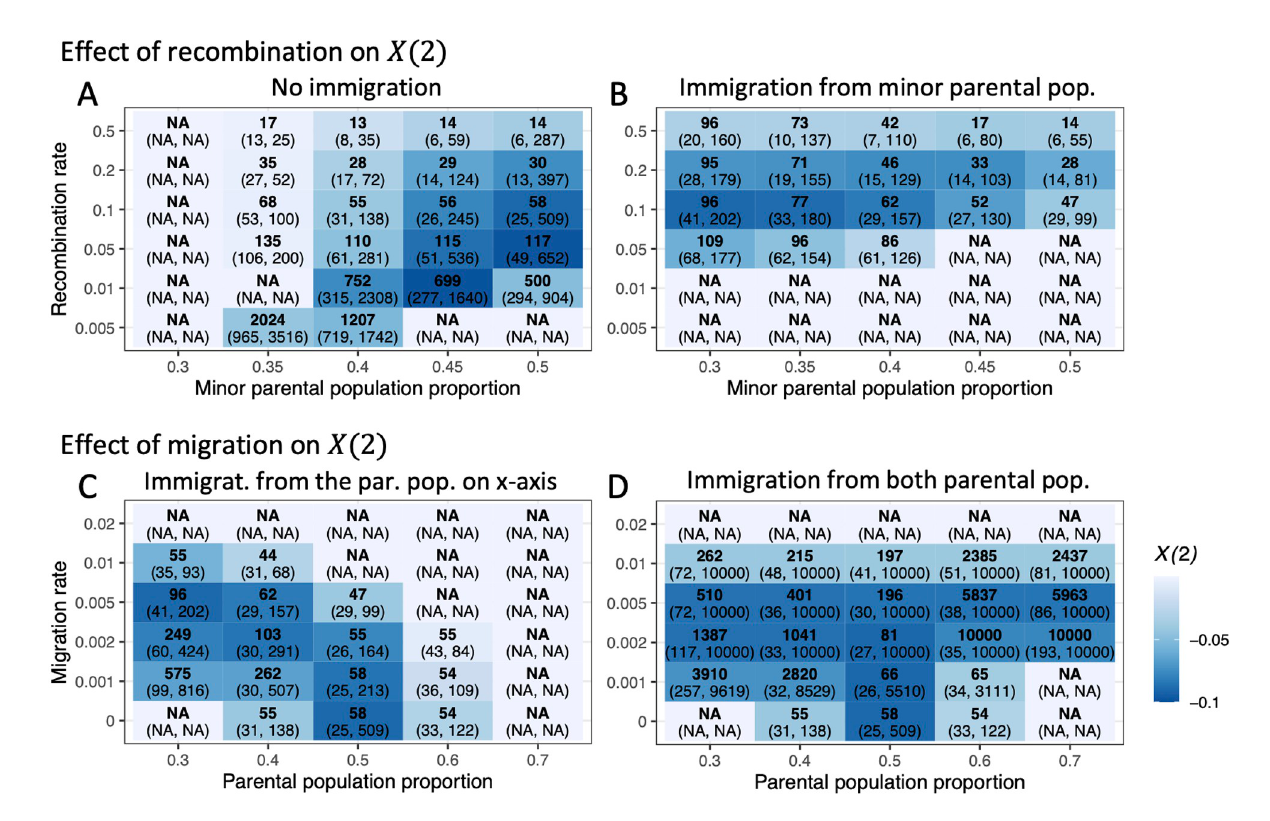
Fig 2. The time window of negative X (2) for a DMI in the deterministic toy model. Generations with the largest – X (2) values are indicated in bold. Time windows for which X (2) is negative for a DMI pair are shown in parentheses. Blue color intensity indicates values of the largest – X (2) observed over that interval. The model parameters used here are α = 0.001, β = 0.002, γ = -0.5. All trajectories were traced until one locus was near monomorphic (minor allele frequency < 0.005 or up to 10000 generations). We considered two parameter sets. One is a range of admixture proportions (x axis) and recombination rates (y axis) without immigration (A) or with immigration from the minor parental population ( m = 0.005, B). A. The DMI left the strongest signal in X (2) for intermediate recombination rates, and the signal was not detected until later generations when recombination rates were lower and admixture proportions were more uneven. B. Immigration from the parental population can narrow or widen the detection window. The other parameter set is a range of admixture proportion (x axis) and immigration (y axis) from one (asymmetric, C) or both parental populations (symmetric, D) when the recombination probability is 0.1. C. Immigration from one parental population can narrow or widen the detection windows. D. Immigration from both parental populations can maintain the signal of long-term DMIs. Note that the observed asymmetry in D stems from the effect of direct selection.